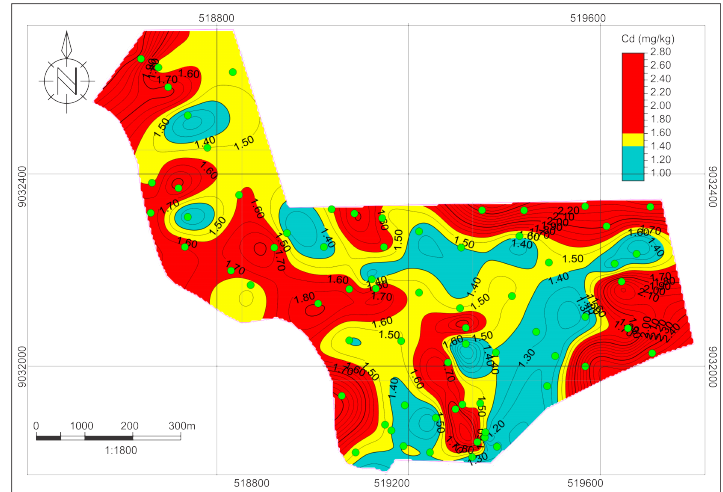
Figure 2. Cadmium Geochemical Map in